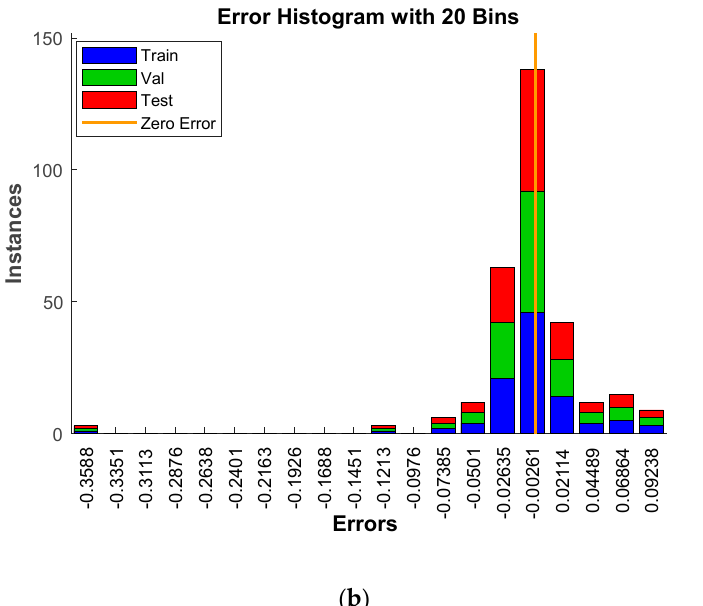
Figure 11. Residuals relating to the model established by the different techniques according to the estimated values: ( a ) frequency distribution of errors, and ( b ) histogram of error values with 20 bins.